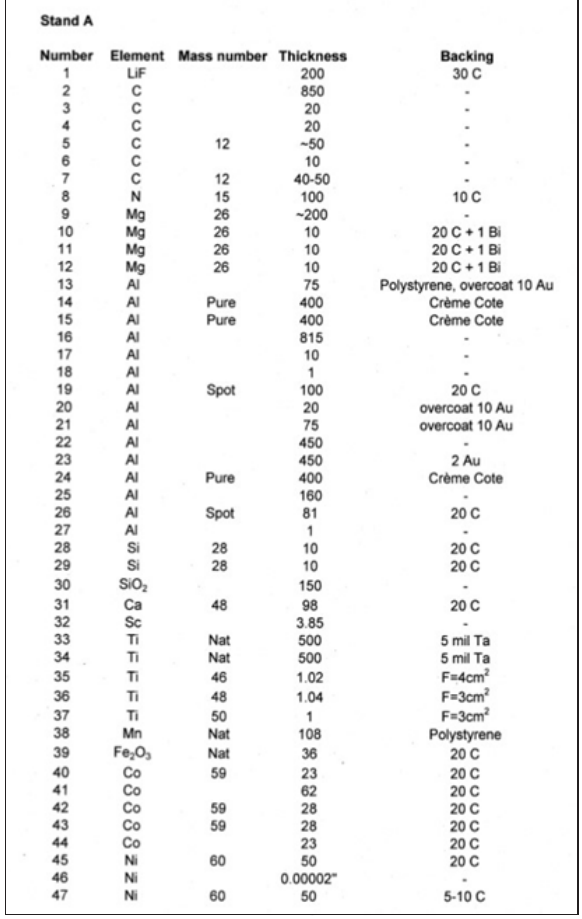
Fig. 2. Example page from the list of BNL